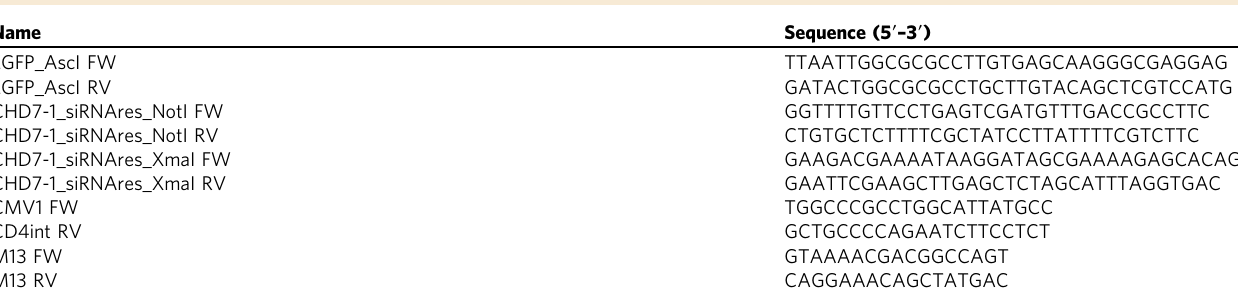
Table 2 List of